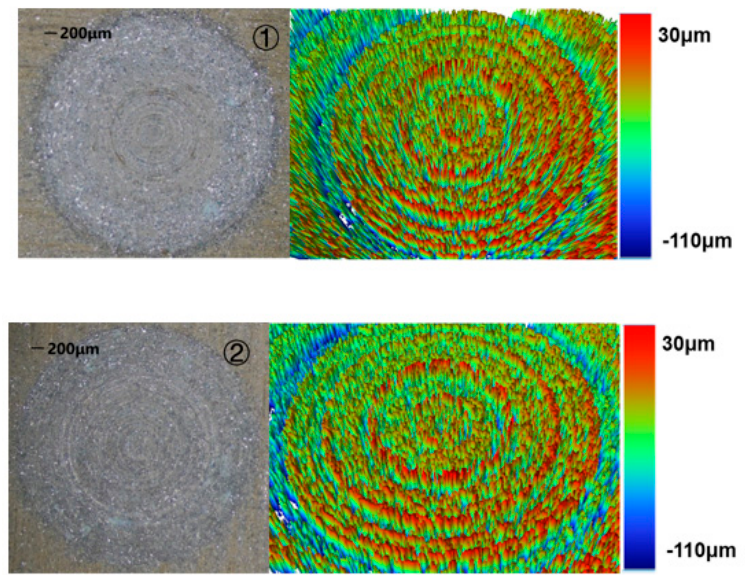
Figure 8. Features of two machining methods. ① Feature of the 1D machining; ② feature of the 2D